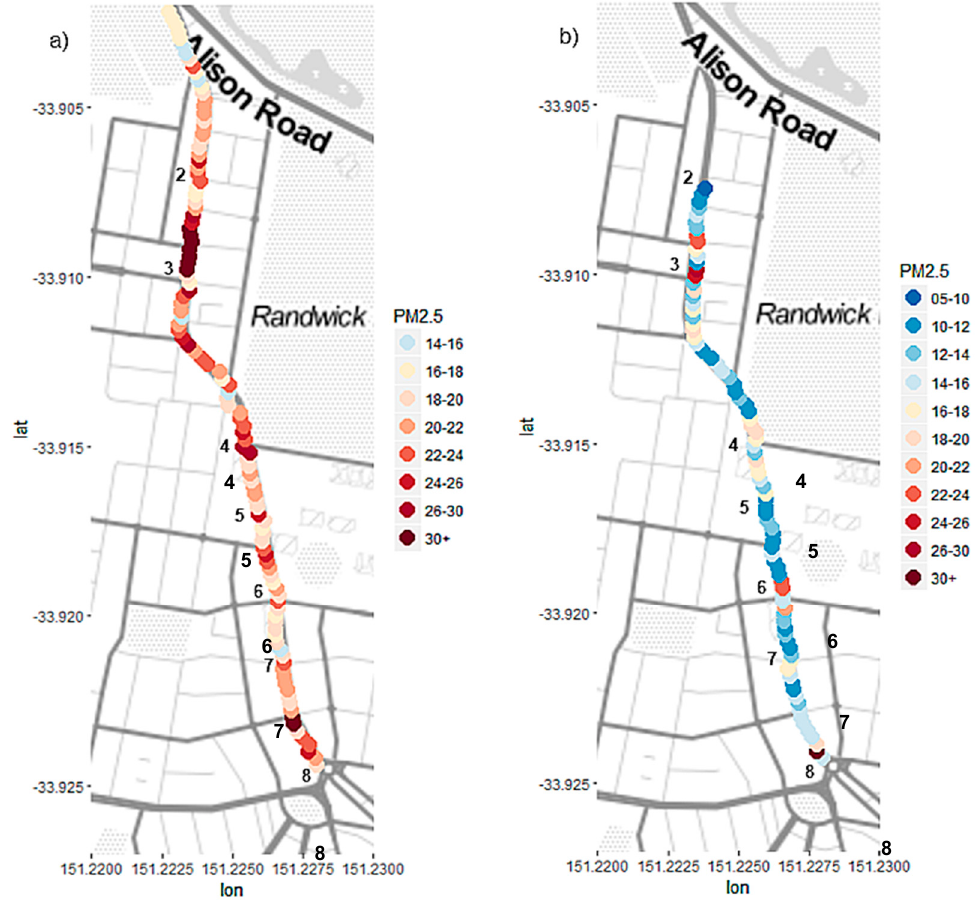
Figure 5. ( a ) ( left ) Averaged morning and ( b ) ( right ) averaged afternoon raw PM 2.5 concentrations observed during 13th to 16th 2017 (along Anzac Parade only). All data was binned into longitudinal gridpoints at an interval of 0.0002 decimal degrees (the smallest spatial resolution available), averaged within each bin, and plotted. Traffic-counting locations are indicated by the corresponding number labels on the figure.